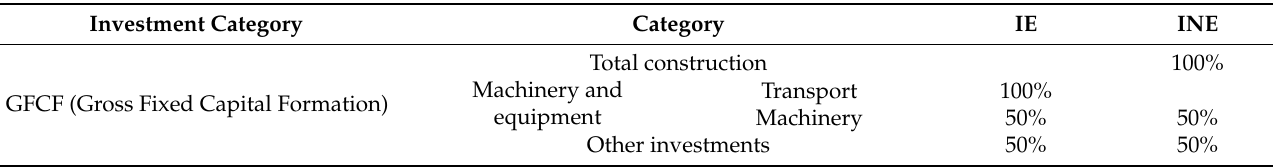
Table A3. Reclassification of the GFCF. (Adapted from